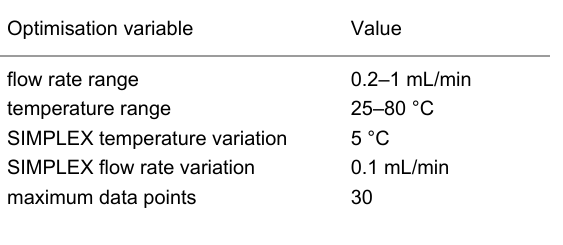
Table 1: Conditions and limits for the optimisation used in tandem with RD1. Ketone 1 concentration 0.40 mmol/L, semicarbazide concentra- tion 1.20 mmol/L.